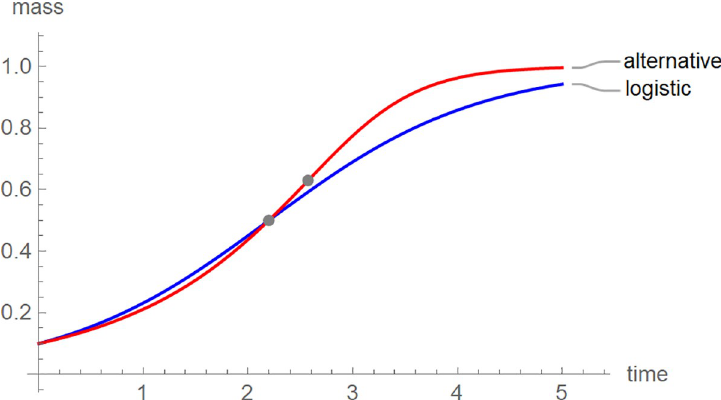
Fig 1. Growth trajectories of logistic growth and an alternative growth model together with the inflection points. The growth curves had the parameters a = 1, b = 2, c = 0.1, p = q = 1 (blue: logistic growth) and a = 1, b = 4, c = 0.1, p = q = 0.7526 (red). The asymptotic limit was 1 (both curves) and the inflection point coordinates (gray dots) were (2.197, 0.5) for logistic growth and (2.572, 0.63) for the alternative curve.